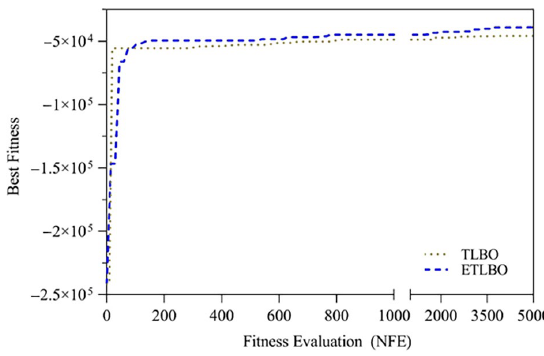
Figure 16. Convergence comparison of ETLBO vs. TLBO